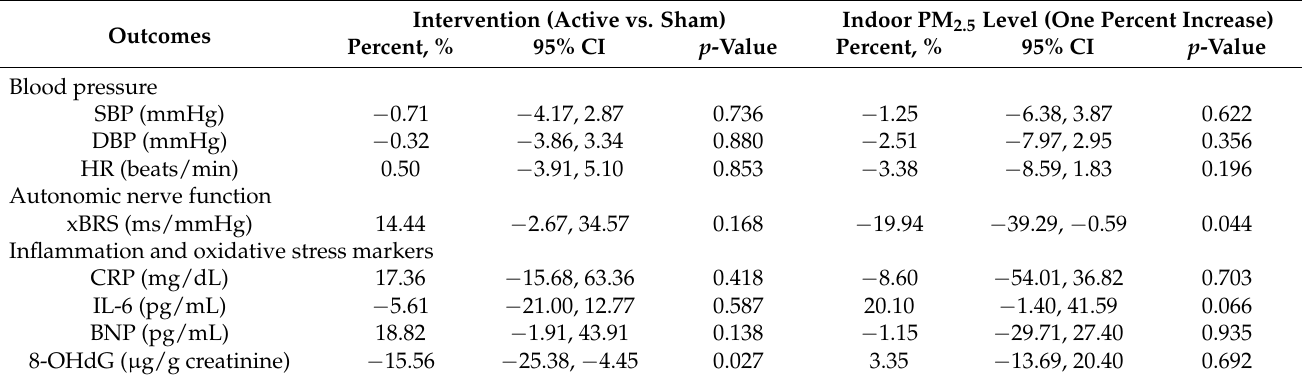
Table 4. Percent changes in blood pressure, inflammation, and oxidative stress markers levels according to intervention phases or change in indoor PM 2.5 . Intervention (Active vs.